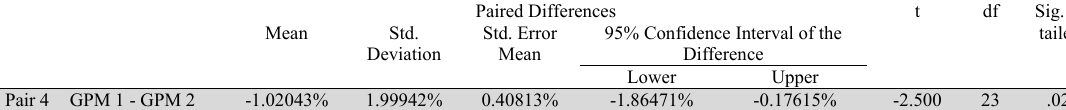
Paired sample T-test SMEs Gross Profit